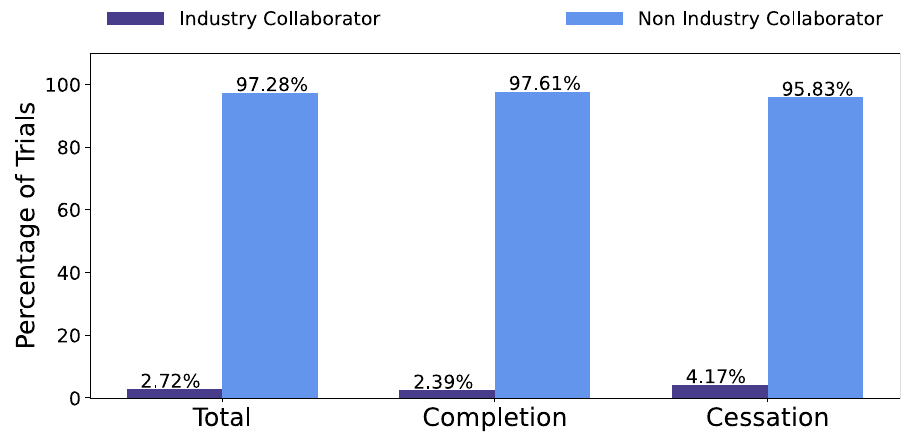
Fig 4. Distribution of trials that have industry collaborator with respect to all trials, completion trials, and cessation trials, respectively.